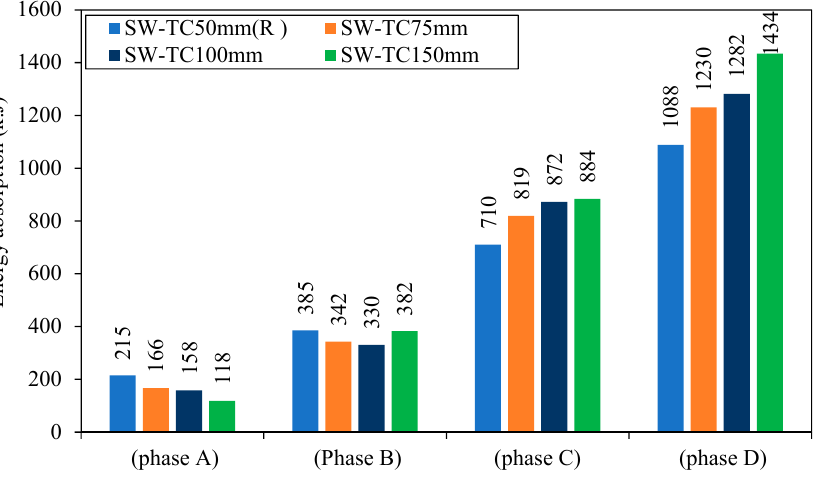
Figure 23. Energy absorption of group 3.